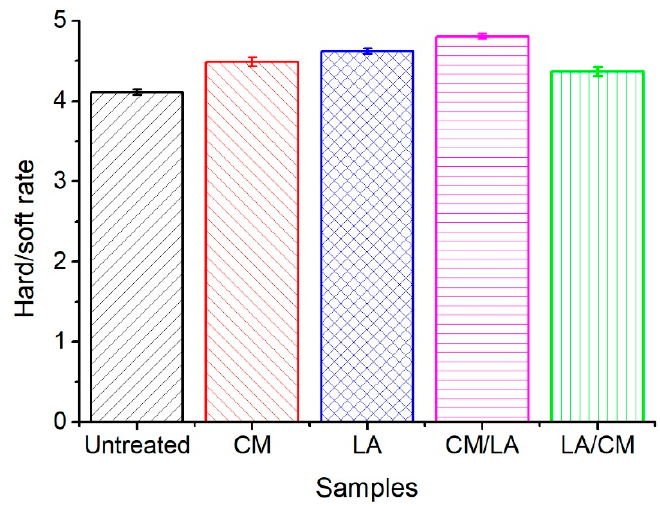
Figure 8. Effect of CM, LA, CM/LA, and LA/CM pretreatments on soft handle of knit cotton fabric.